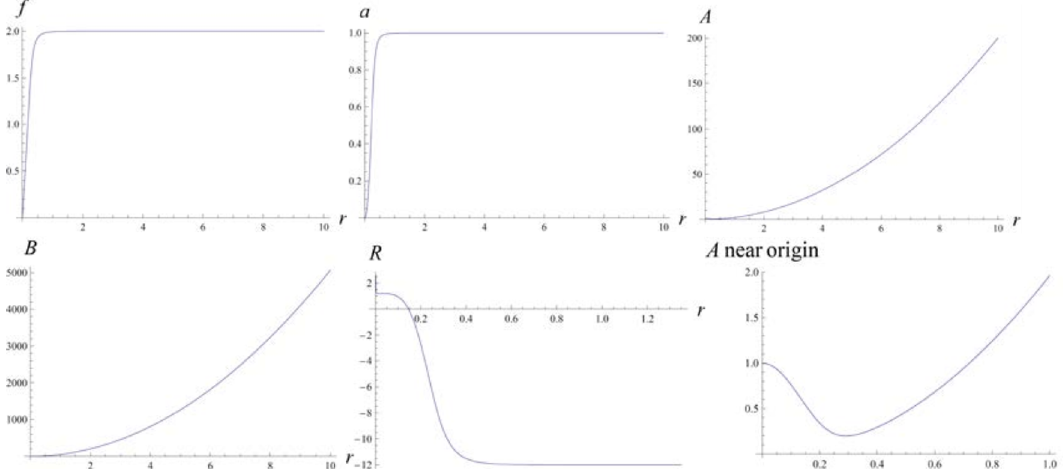
Figure 4 . Case IV: n = 1 , v = 2 and Λ = − 2 . This case differs from the previous three because v = 2 instead of v = 1 (hence f plateaus at 2 ). The mass of the vortex is considerably greater now compared to the previous three cases (see table 1 of values) which reflects the v 2 dependence of the integral mass formula (3.12). There is a significant dip in the metric A near the origin while it remains positive (no horizon). This reflects a significant departure of the metric near the vortex from its asymptotic BTZ black hole form (which has an r 2 dependence).